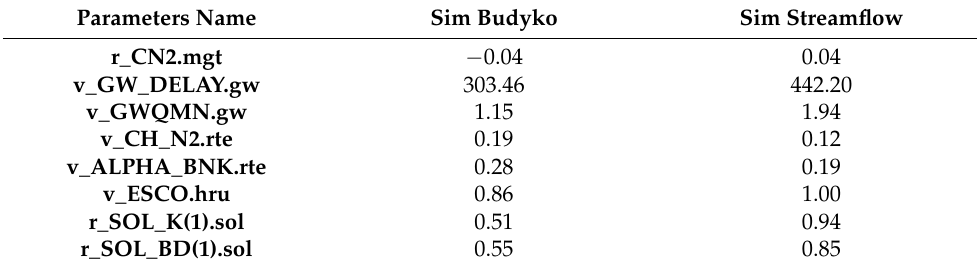
Table 6. Optimal parameters calibrated for two calibration